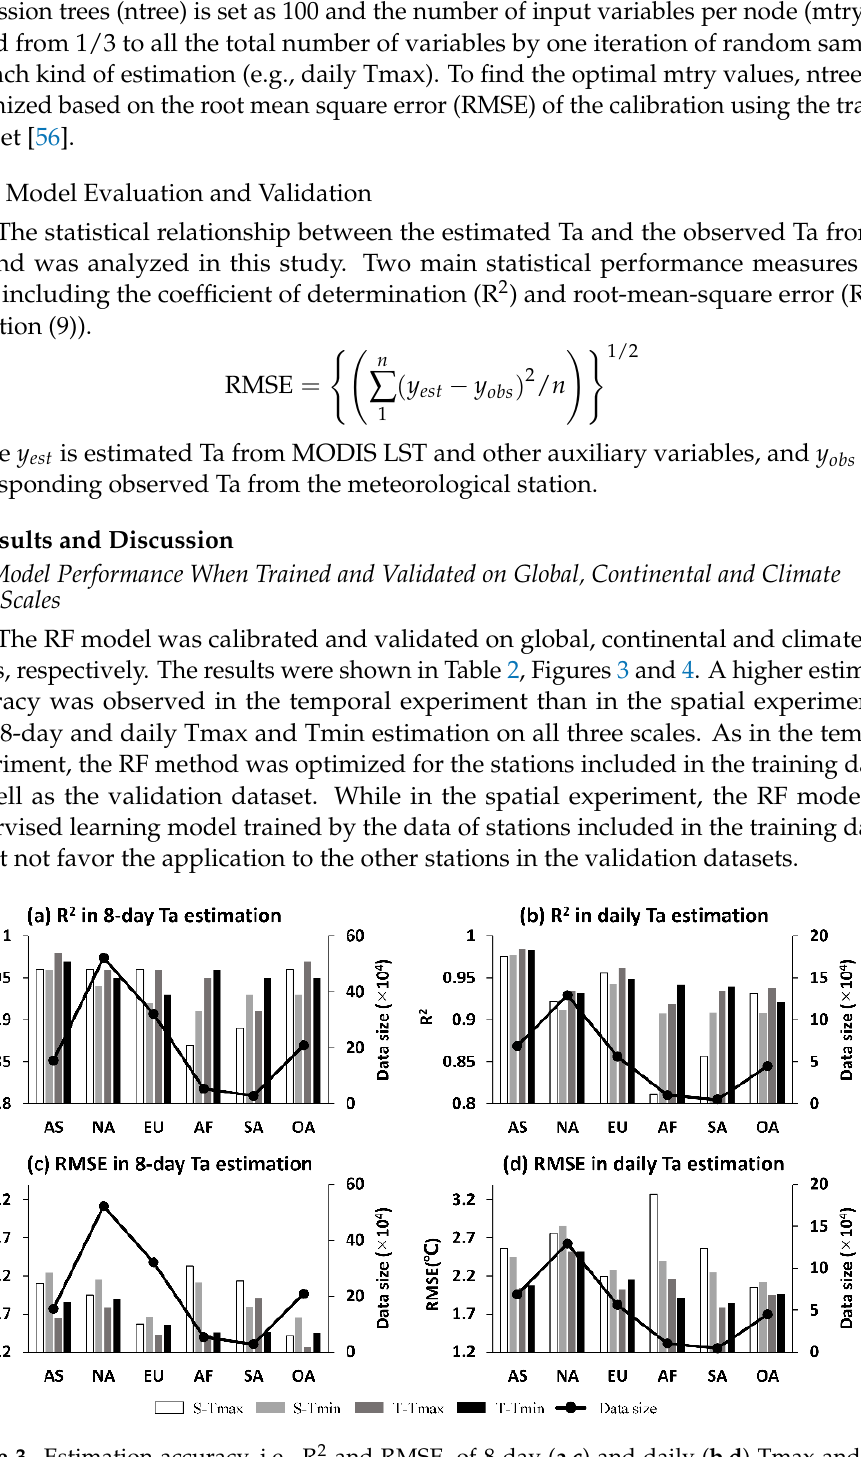
Figure 4. Estimation accuracy, i.e., R 2 and RMSE, of 8-day ( a , c ) and daily ( b , d ) Tmax and Tmin in both spatial and temporal experiments on a climate zone scale. 3.2. Model Performance When Trained and Cross-Validated on Global, Continental and Climate Zone Scales Figure 5 shows the averaged 8-day and daily Tmax and Tmin estimation accuracy of involved stations in spatial experiments when using the model trained and cross-vali- dated at different scales. For example, Figure 5c shows the 8-day Tmax and Tmin estima- tion accuracy at each climate zone when using the models trained on a global and climate zone scale, respectively. As shown in Figure 5a,b, both 8-day and daily Ta estimation accuracies using the model trained on a continental scale (hereafter continental model) were higher than those using the model trained on a global scale (hereafter global model) in terms of RMSE in each continent except daily Tmin estimation in South America. In addition, the corre- sponding accuracy differences between the global and continental models tend to be more significant in the continents with sparse observation stations, e.g., Africa, and not obvious in the continents with more observation stations, e.g., North America because on the global scale, the training data from the NOAA dataset is strongly biased towards America and Europe in terms of the station density, data quantity and even data quality and not favored to Africa and South America. Therefore, the global model tended to be biased in